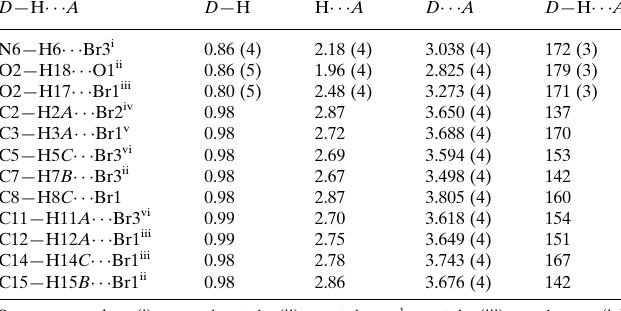
Hydrogen-bond geometry (A˚ , (cid:4)